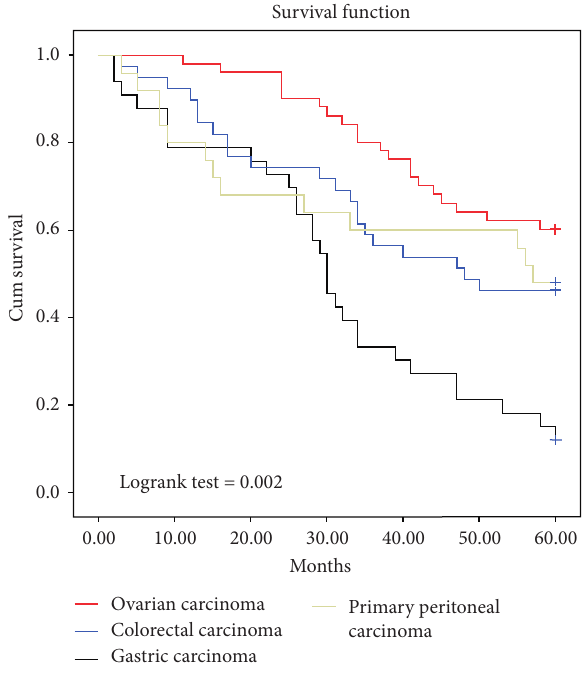
Figure 3: Survivability of study